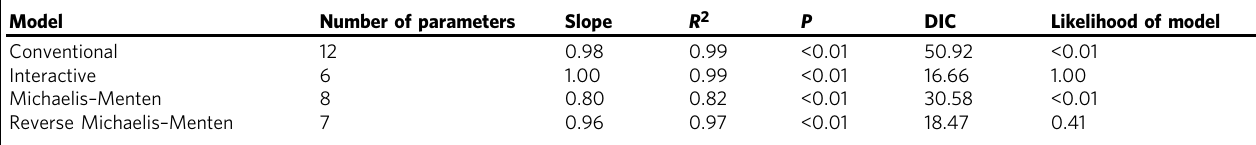
Table 1 Performance of models in simulating SOC dynamics with replenishment and priming Model Number of parameters Slope R 2 DIC Likelihood of model